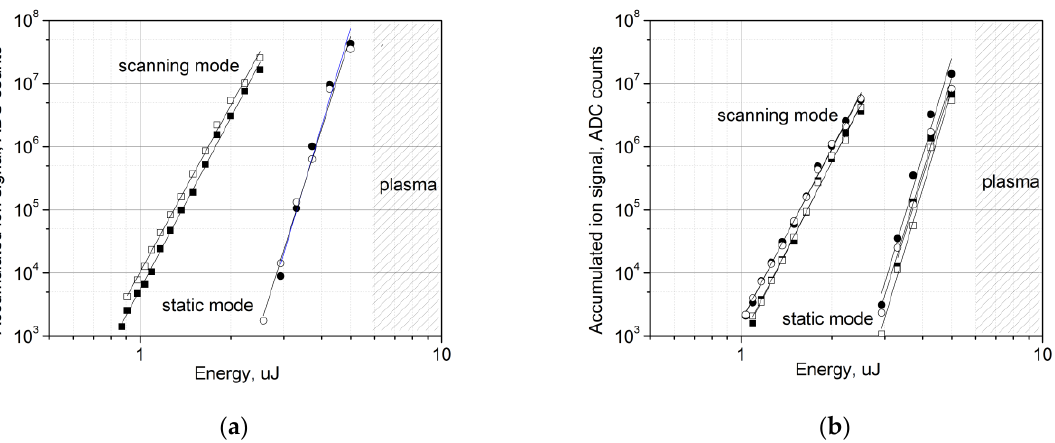
Figure 4. ( a ) The dependences of the accumulated ion signal vs. laser pulse energy for the positive (filled symbols) and negative (open symbols) Au ions as measured in scanning mode and in static mode. ( b ) The dependences of the accumulated ion signal vs. laser pulse energy for the positive (filled symbols) and negative (open symbols) Au 2 (circles) and Au 3 (squares) charged clusters as measured in scanning mode and in static mode. Each point on the plot corresponds to 17,400 accumulated successive single mass spectra (100 s time interval). An approximation of the experimental data by a power function is shown by the solid lines. The hatching highlights the region of plasma formation.